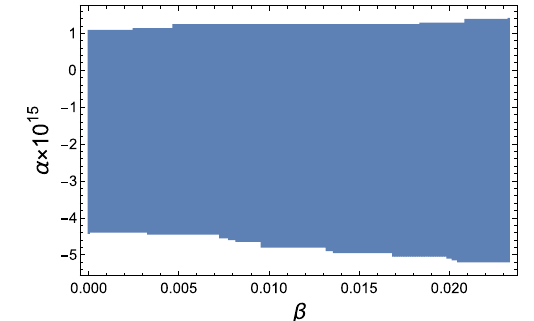
Fig. 1 Theconstraintonthecouplingconstant α andthemodelparam- eter